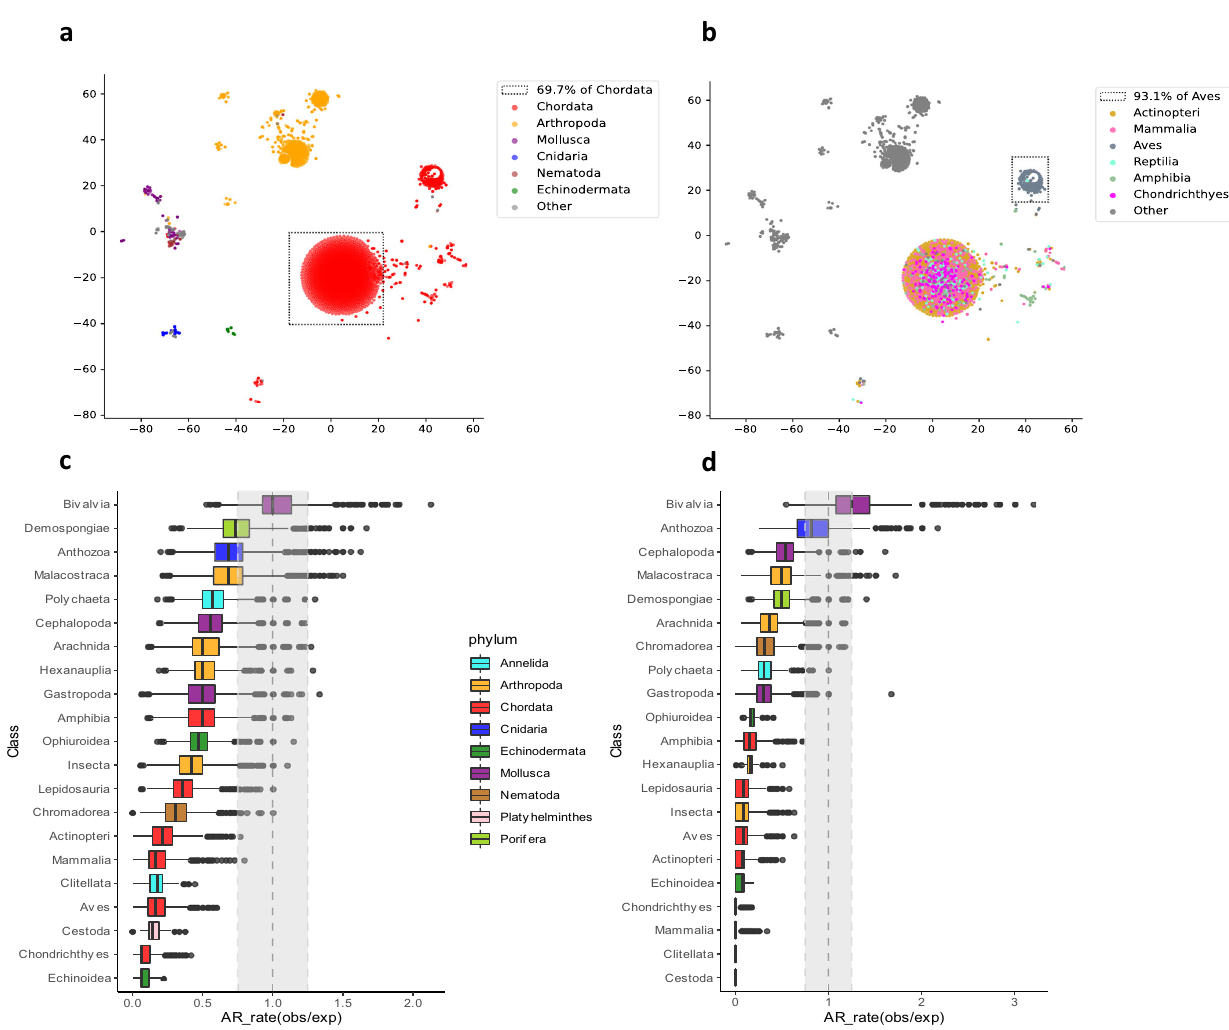
Fig. 2 MtDNA gene order is more conserved within than between phyla. a , b . tSNE plots of all organisms within the analyzed database, colored either by phylum ( a ) or while highlighting classes within Chordata ( b ). Dotted frame — Chordates in ( a ), birds in ( b ). c , d Ratio between observed and expected genome architecture (AR rates) within each class, either with ( c ) or without ( d ) mt-tRNA genes. The vertical dashed line and grey rectangle show 1:1 ratio (indicating no difference) and ±0.25 interval around it, respectively. The expected AR-rate distribution was calculated by random sampling of 21 organisms from each class followed by label shuf fl ing 10,000 times. The observed distribution was generated by a similar process but without shuf fl ing. See also Supplementary Data S5 and S6 for raw data (https:// fi